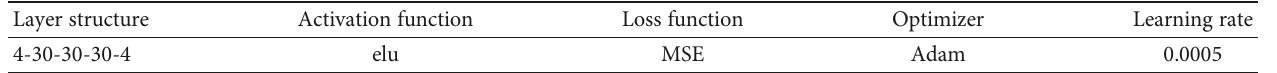
Table 5: Hyperparameter con fi guration of the basic model: VBE system with four modes. Layer